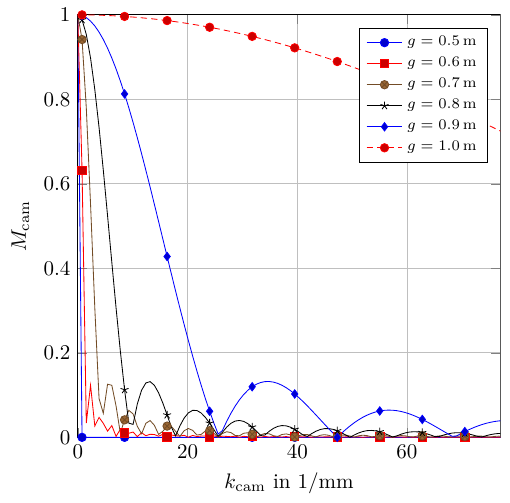
Figure 1. Camera MTF of deflectometric camera, plenoptic camera and camera with diffraction-limited lens.